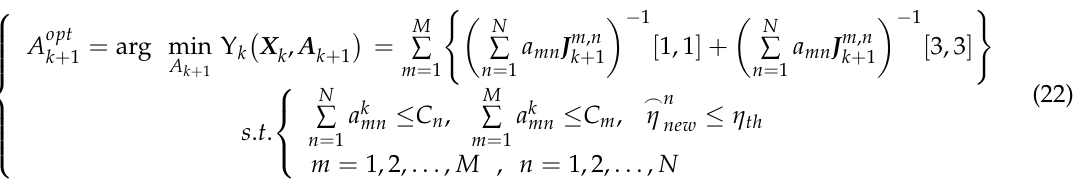
Figure 4. Change curves of IPF